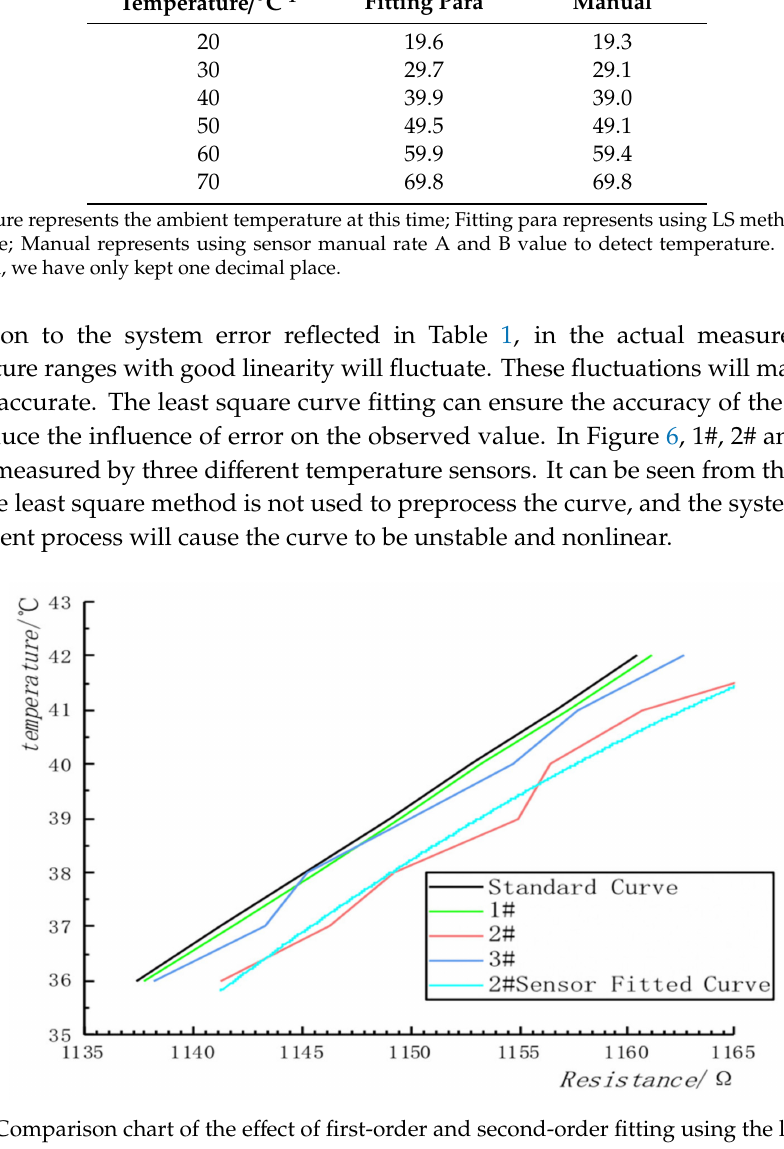
Figure 6. Comparison chart of the e ff ect of first-order and second-order fitting using the least square method. The resistance on the way is the resistance of the